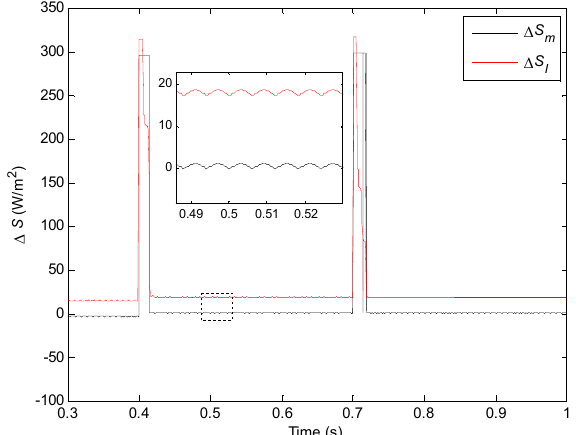
Figure 22. ∆ S I curves under increasing S conditions. I